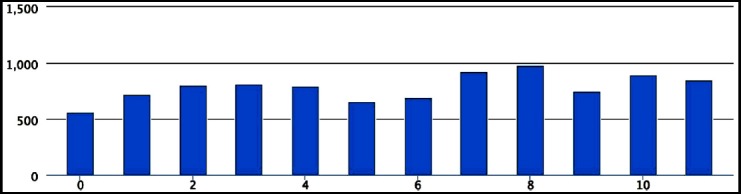
Shows minimum macular hole diameter in 12 study cases. X axis shows macular hole diameter in um.